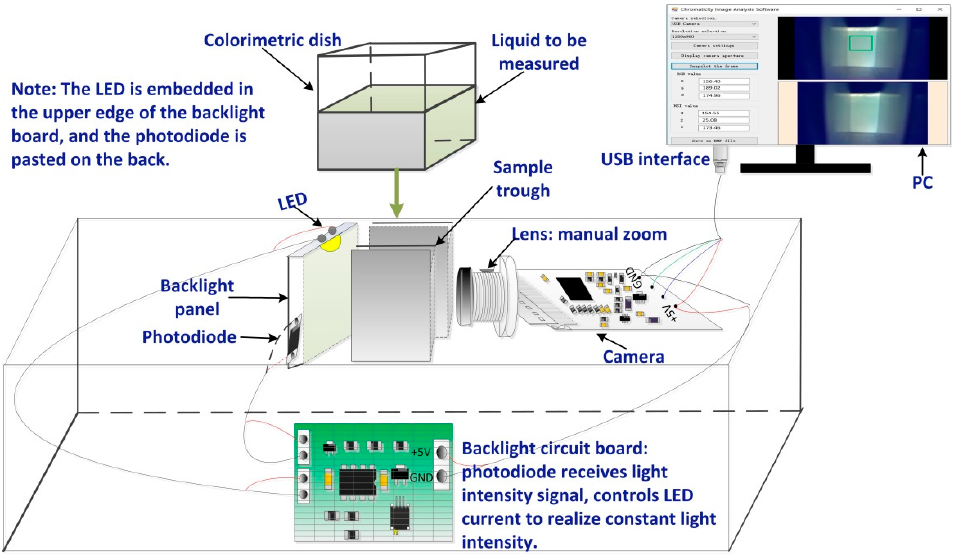
Figure 1. Structure of a water chromaticity measurement system.